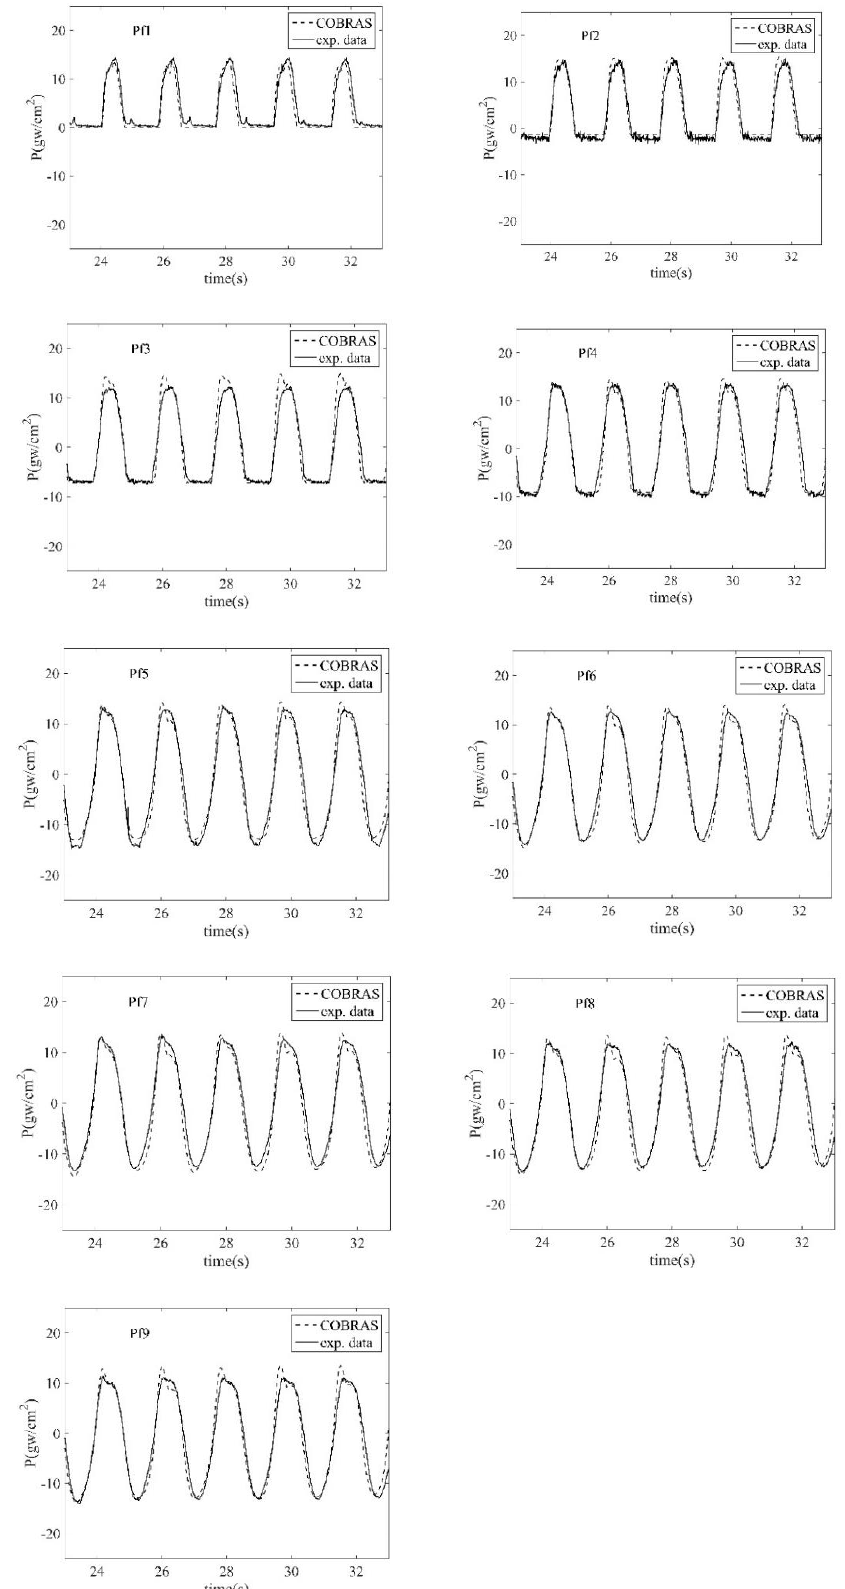
Figure 5. The comparison between numerical model and laboratory measurement for the time series of dynamic wave pressure on the seaward